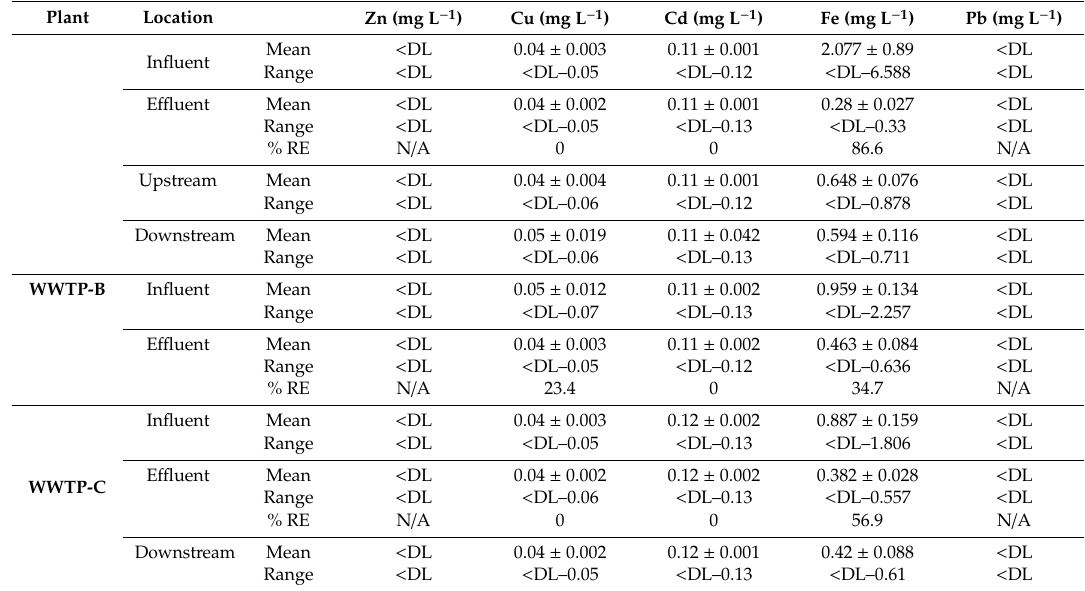
Table 1. Levels of heavy metals in wastewater and surface water from WWTP-A, B and C (mg · L − 1